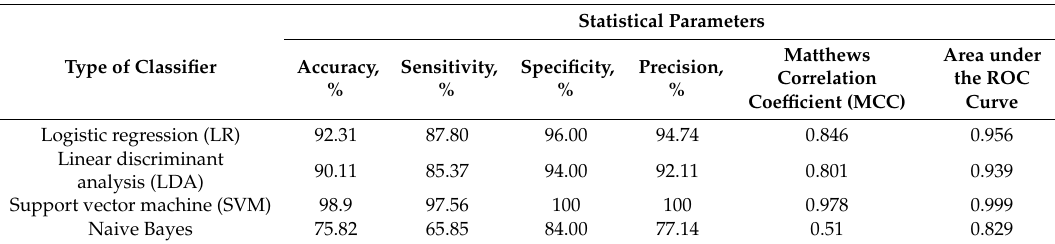
Table 5. Performance of classifiers by combining optical dermatoscopy, spectrophotometry (melanin, blood and collagen) and HFUS imaging